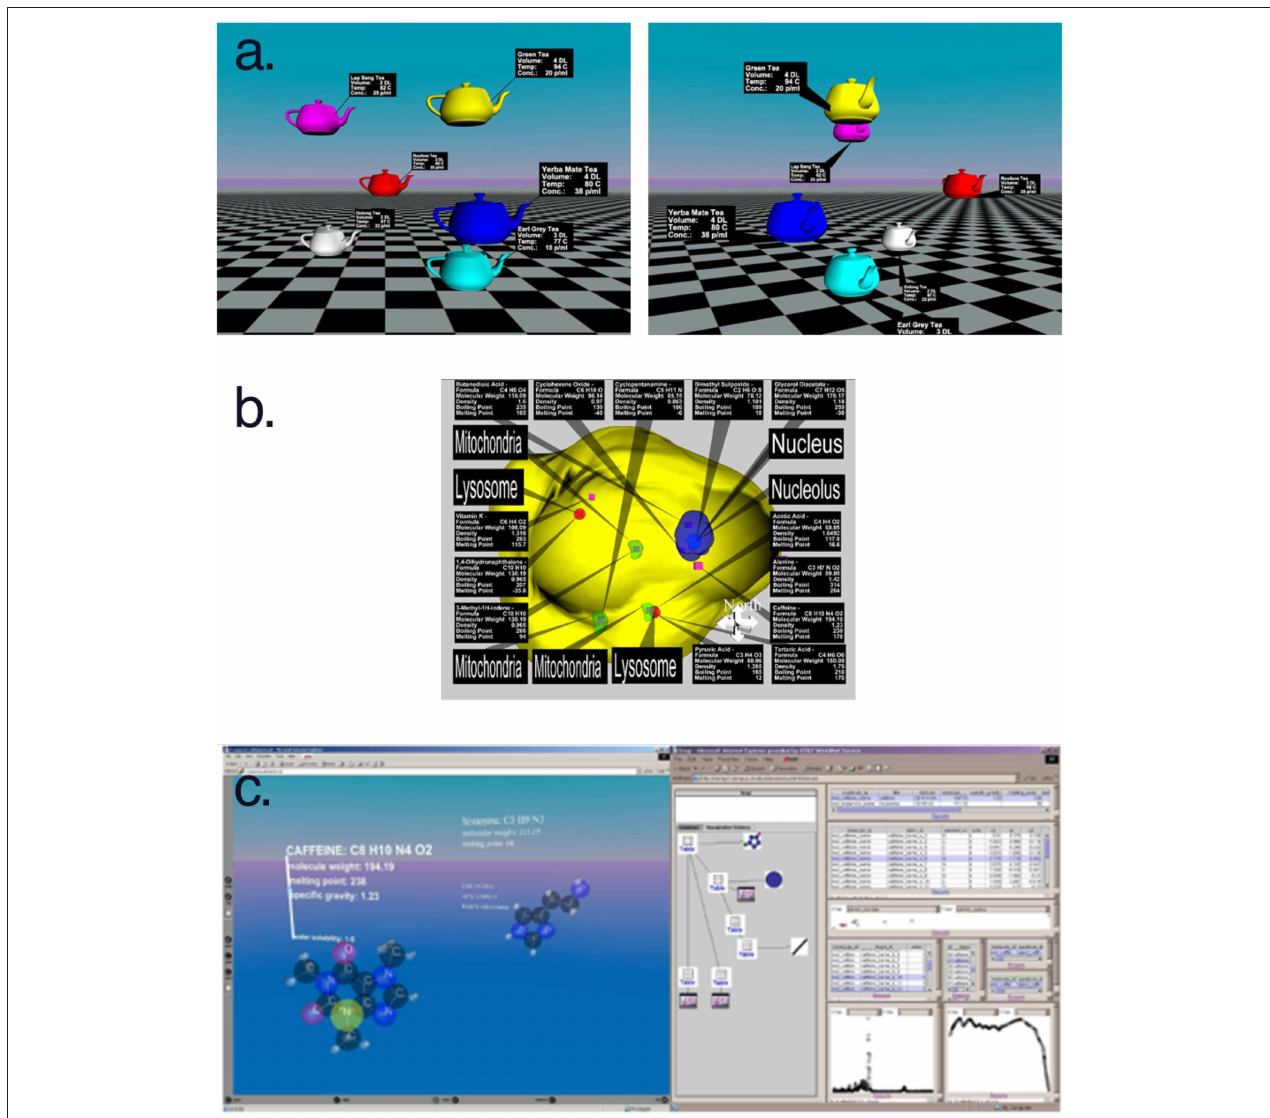
FIGURE 3 | IRVE layout spaces provide support for immersive analytics through displays and interactions in (a) object space, (b) viewport space, and (c) display